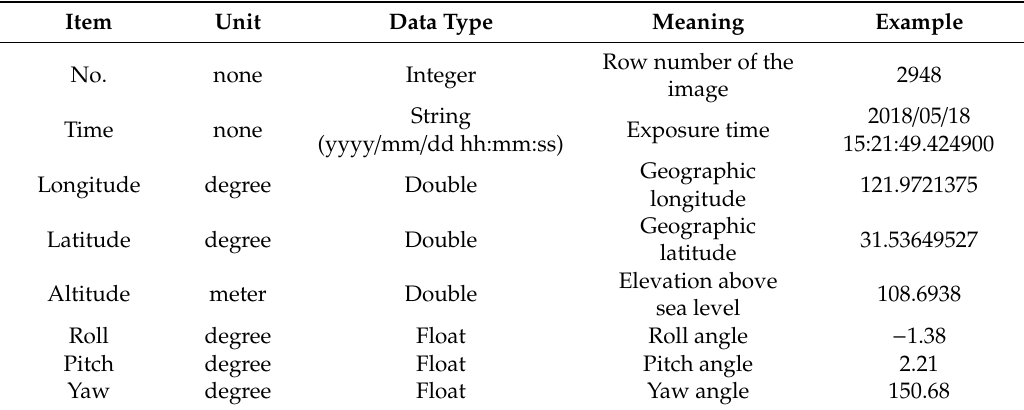
Table 2. Entries recorded by global-positioning system combined with an inertial measurement unit (GPS / IMU) file in ASCII